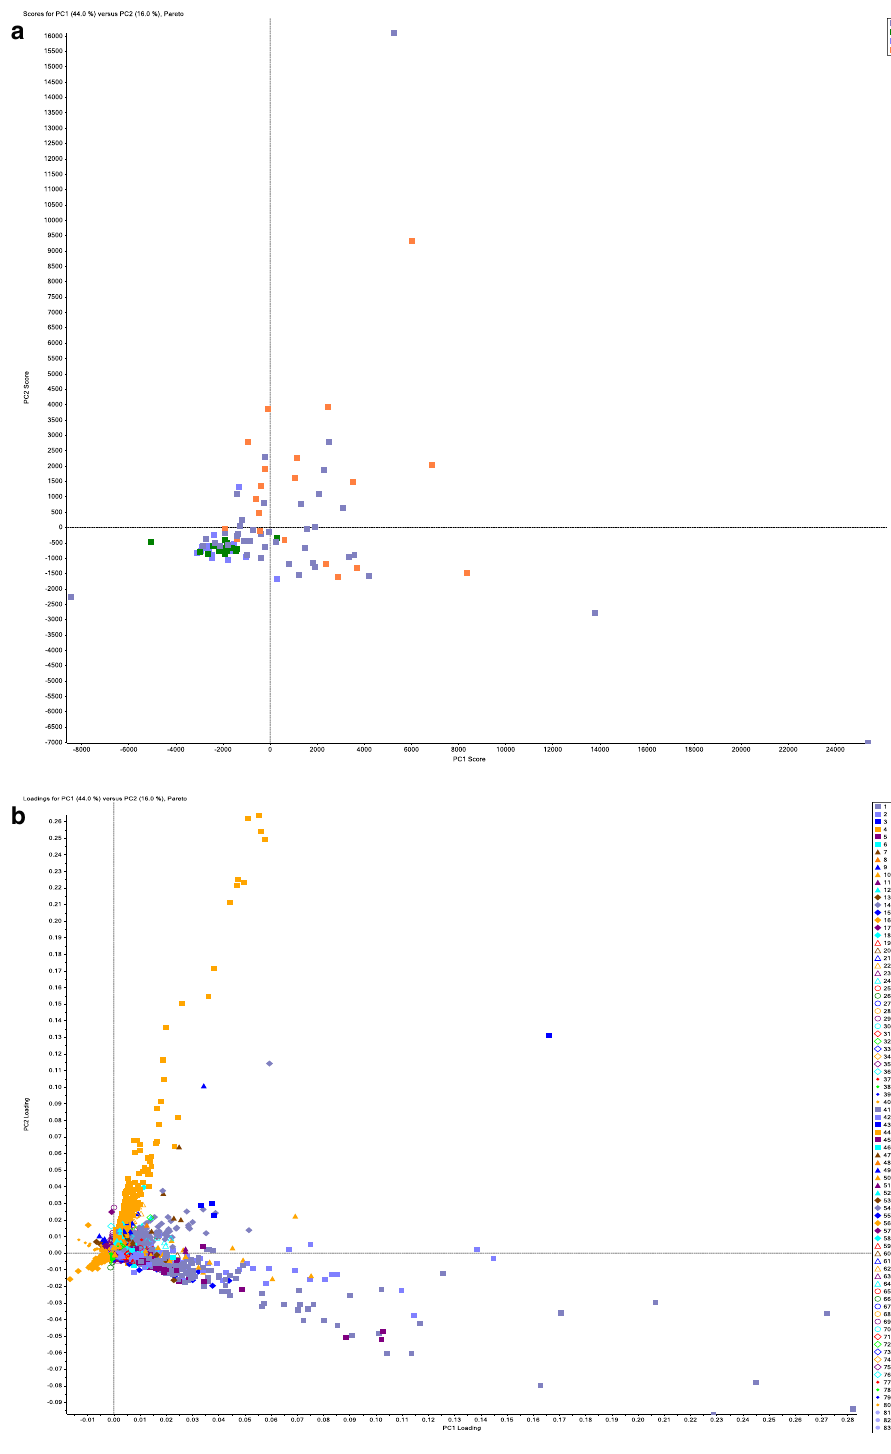
Figure 1. Metabolomics analysis of plasma samples. ( a ) Scoring plots from PCA model analysis of the full-scan MS analysis for classifying COVID 19 infected (dark purple and orange squares) and control groups (light purple squares: uninfected male, green square: uninfected female). and ( b ) loading plots from PCA model analysis in which each metabolite is represented by a distinct color as shown in the graph legend ( c ) Profile of an identified regulated metabolite, via loading component analysis, as represented by peak area across COVID- 19-infected and control samples, such metabolites drives the observed separation seen between the cohorts in a PCA model analysis, using MarkerView software by SCIEX.